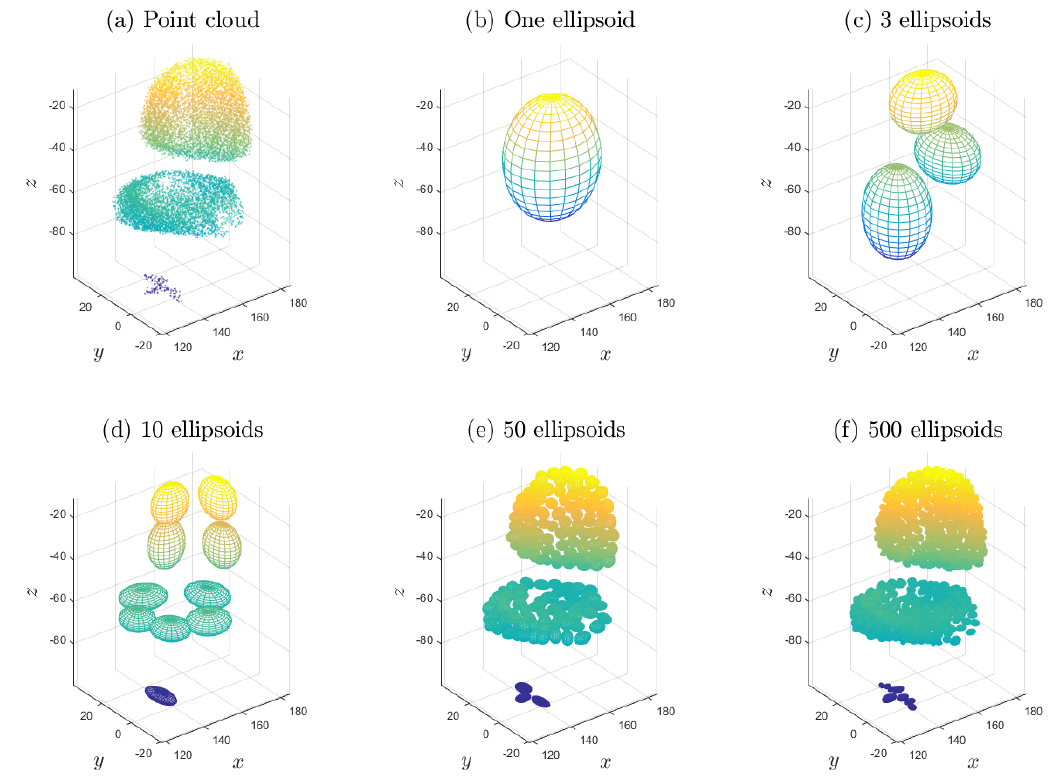
Figure 8. Experiment